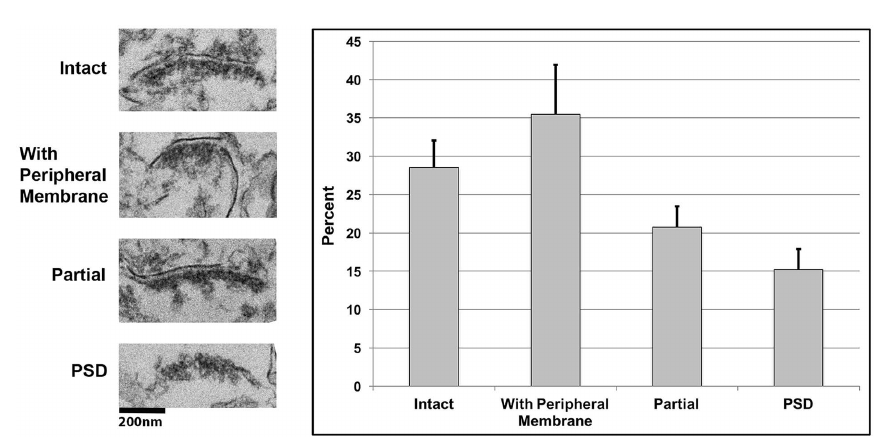
Fig 2. Assessment of the optimized synaptic junction preparation by electron microscopy. Four different synaptic junction fractions were evaluatedby electron microscopy. Every recognizablesynaptic structure with a postsynapticdensity (PSD) was countedand classifiedinto one of the four categories. Ideal synapticjunctions devoidof peripheral membranes and without damageto the cleft membranes were identifiedas ‘intact’. Synaptic junctionswith some undigested peripheralmembranes were categorized as ‘with peripheral membranes’. Synapseswith some damage to the cleft membranes were identifiedas ‘partial’, whilesynapses with total loss of membranes were countedas ‘PSDs’. The bars represent percentagesfor each type of synapticstructure as a mean of four experiments. The error bars represent the standard error of the